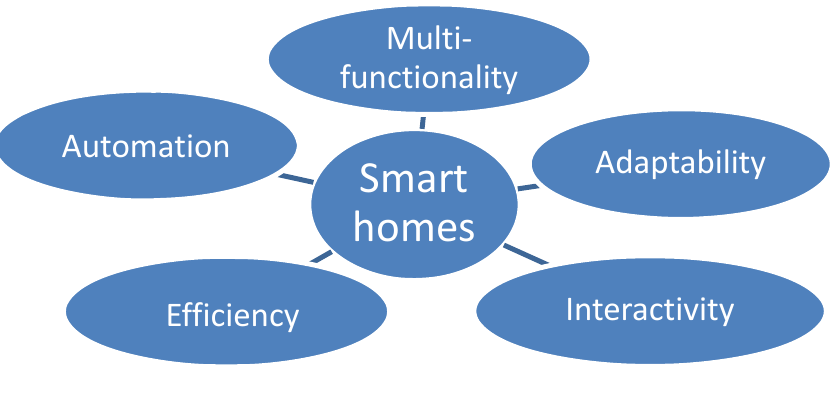
Figure 1. Conceptual framework of smart